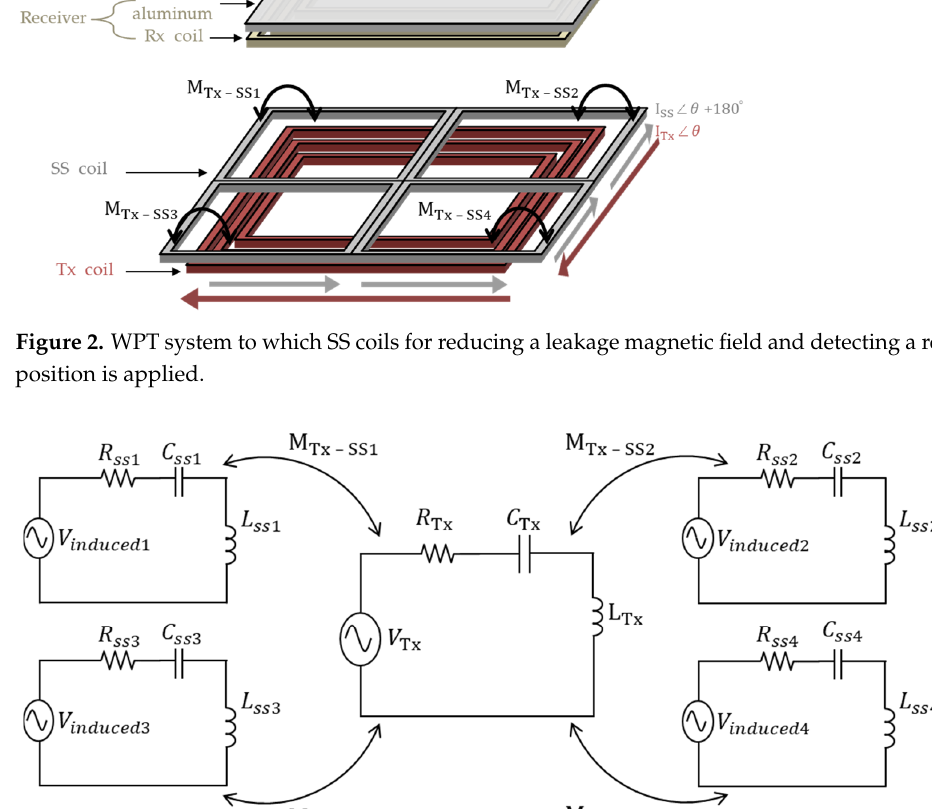
Figure 2. WPT system to which SS coils for reducing a leakage magnetic field and detecting a re- ceiver position is applied.